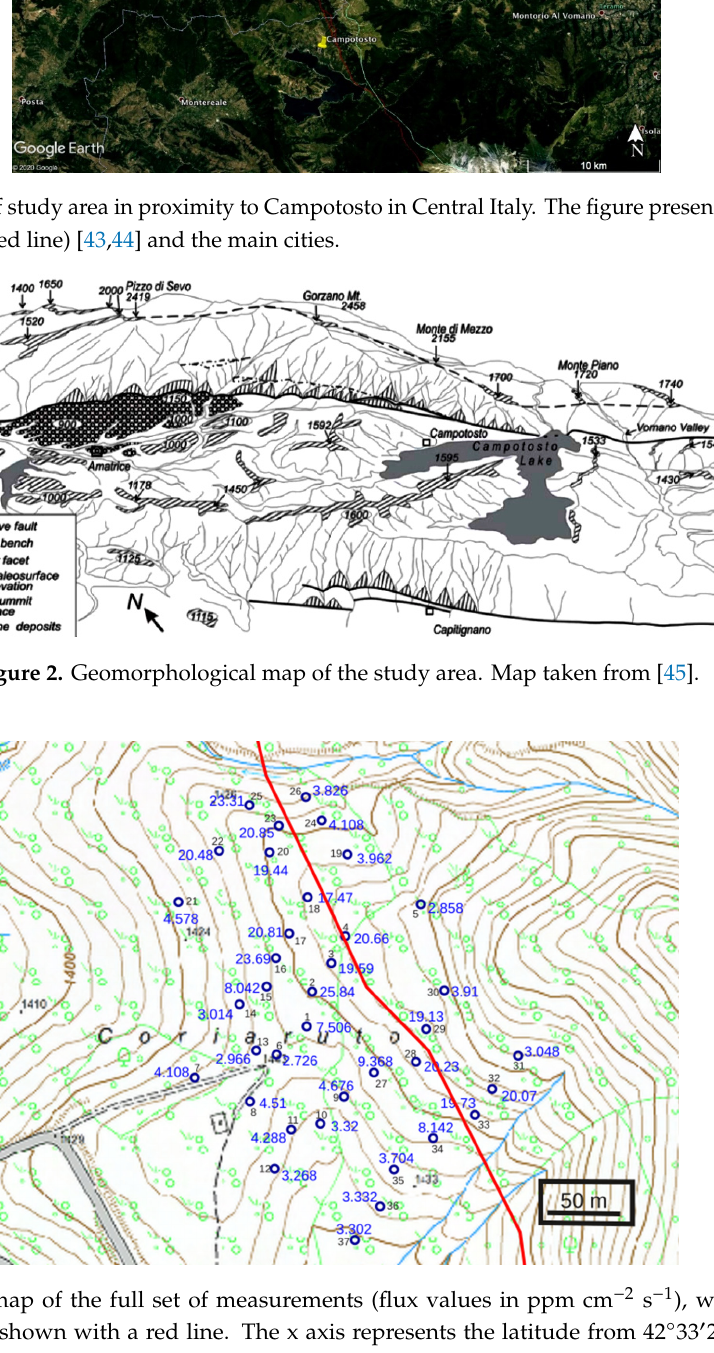
(b) Figure 4. The best-line fits of the two tests: the first, ( a ) reports the increasing concentration test, while the second, ( b ), the decreasing concentration test. In both figures, the x axis (ppm CO 2 (d)) reports the CO 2 concentrations driven into the flux chamber unit, while the y axis (ppm CO 2 (m)) reports the CO 2 concentrations measured. The measurements carried out in the Campotosto area to delineate the CO 2 flux profiles of the Mount Gorzano fault and its vicinity are shown in Figure 3 The map shows the 37 CO 2 flux measurements that were performed at various distances and positions from the fault. The maximum flux measured was 25.84 ppm cm − 2 sec − 1 , and the minimum one was 2.858 ppm cm − 2 sec − 1 . As can be observed from Figure 3, high CO 2 flux values (from 20 to 25 ppm cm − 2 sec − 1 ) are found near the fault, while, on the contrary, lower flux values (from 2 to 4 ppm cm − 2 sec − 1 ) can be observed in positions far from it. Tectonic fracture is related to the deformation pattern along the fault system and also facilitates a pathway for the CO 2 gasses [50–52], therefore leading to elevated fluxes near the fault. It should be noted that the soil CO 2 flux can be influenced by the rock type and by other parameters like chemical, physical and biological processes, including the soil temperature and atmospherical pressure [28,53]. Since the confirmation of the above observations needs further analysis, it is crucial that appropriate methods are employed. A significant approach towards this is monitoring the spatial fractal behavior of the CO 2 fluxes [29,36]. In association, it is significant to mention that the measurements were conducted following, as much as possible, the perpendicular direction (45°